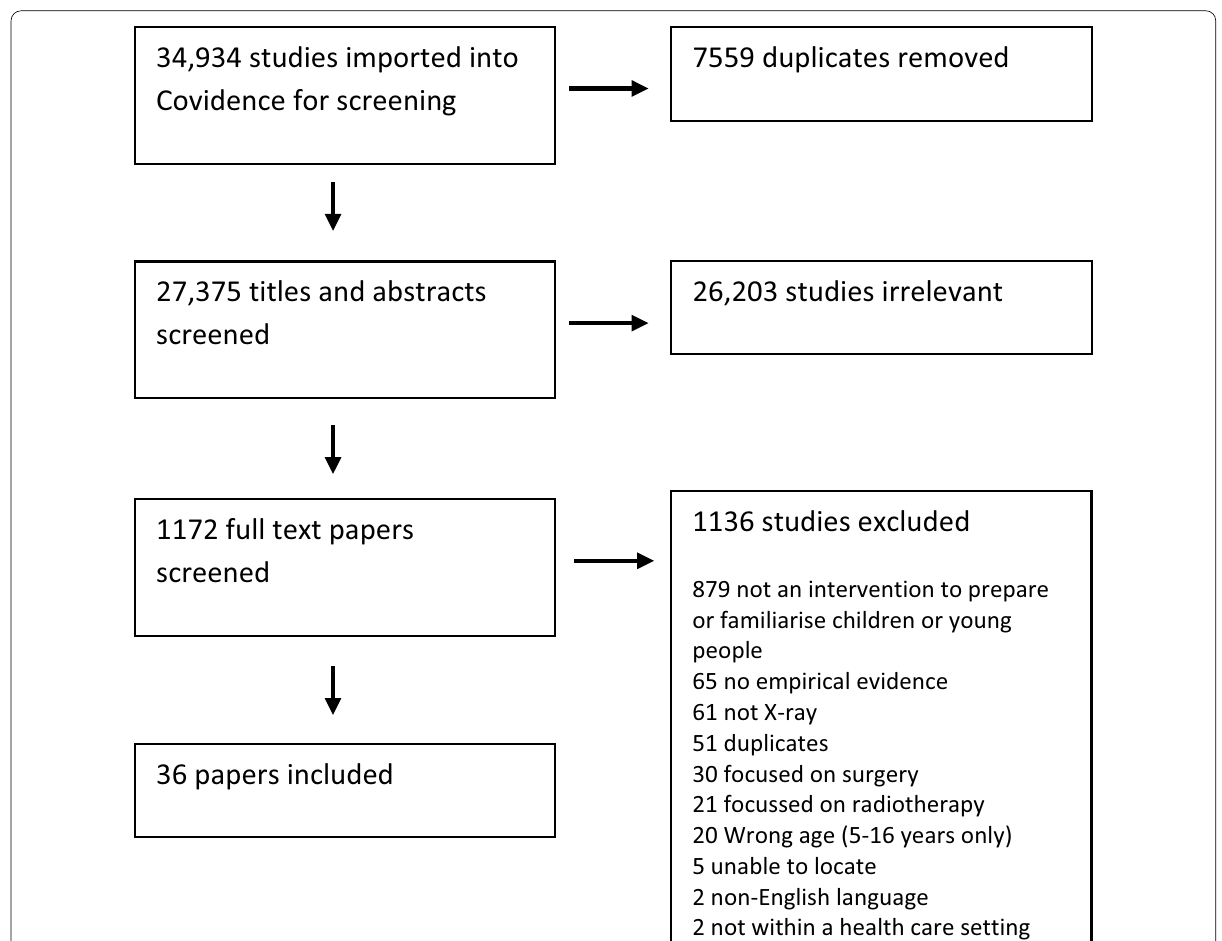
Fig. 1 Preferred Reporting Items for Systematic Reviews and Meta-Analyses